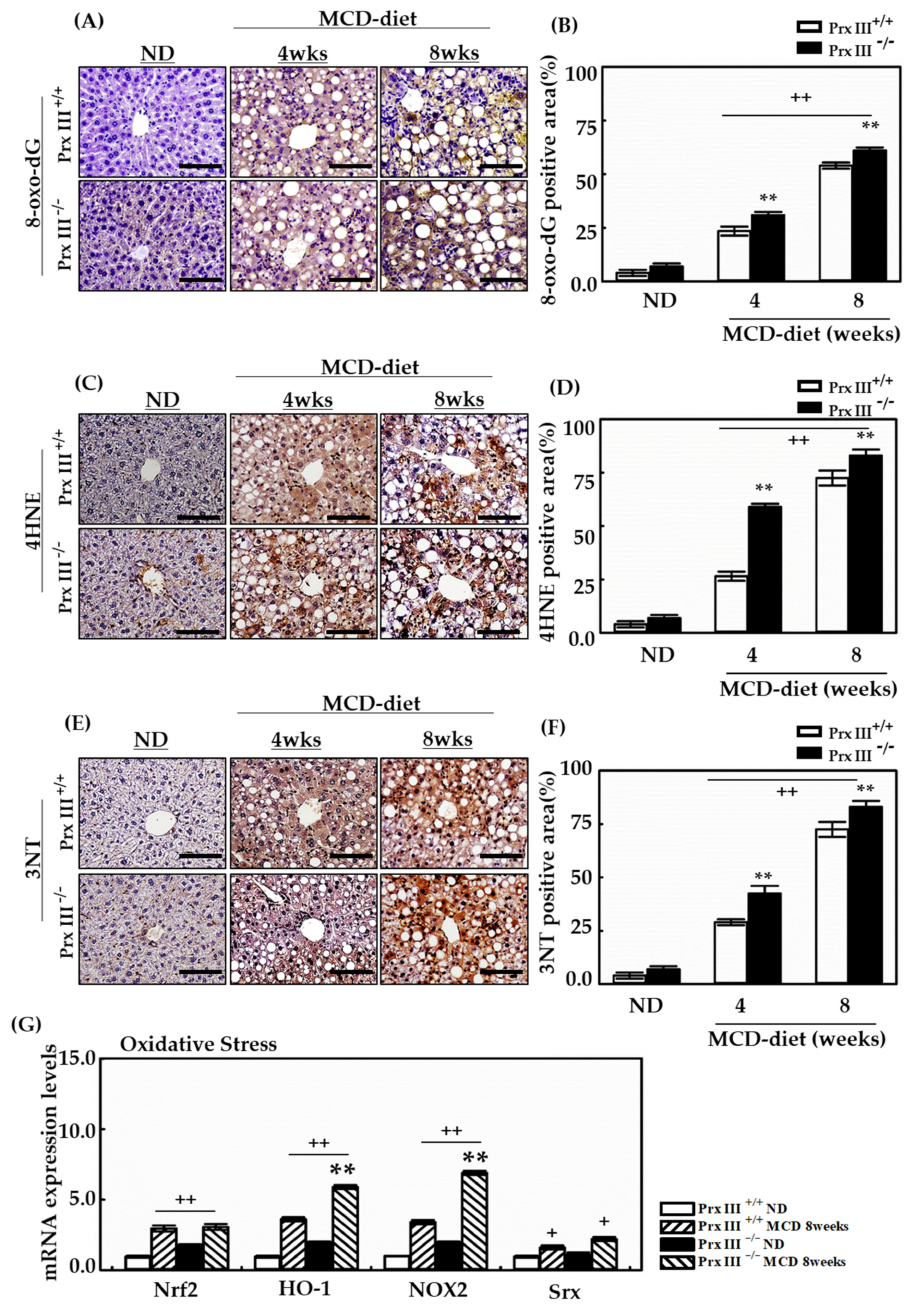
Figure 4. Effects of Prx III on oxidative damage. The effects were assessed in Prx III +/+ and -/- mice fed the MCD diet for 4 and 8 weeks by the staining of 8-oxo-dG, 4HNE, and 3NT, and through determination of mRNA expression levels associated with oxidative stress. Mice were sacrificed at 4 and 8 weeks. Liver tissues were fixed with 4% formaldehyde in phosphate-buffered saline at 4 ◦ C overnight and embedded in paraffin. ( A – F ) The 4 µ m thick liver sections were stained for